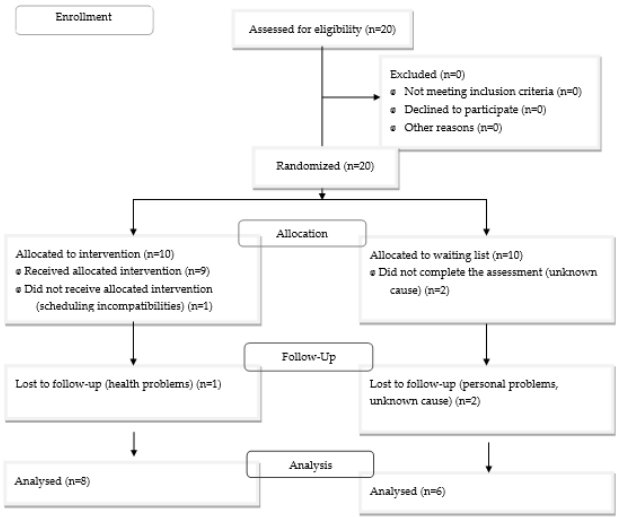
Figure 1. CONSORT flow diagram.